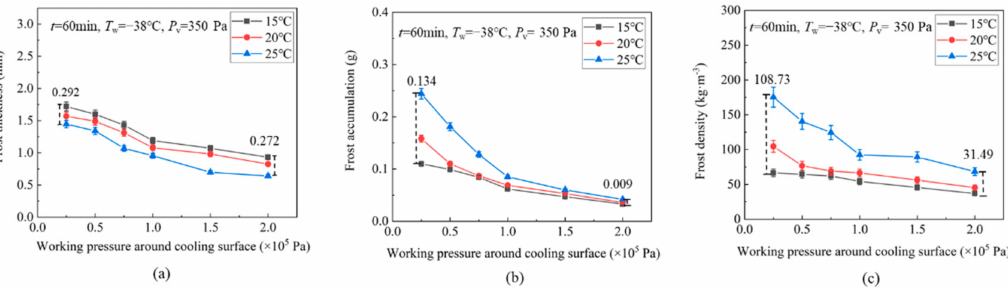
Figure 11. ( a ) Frost thickness; ( b ) frost accumulation; ( c ) frost density with working pressure around cooling surface under different temperatures of humid air at 60 min.